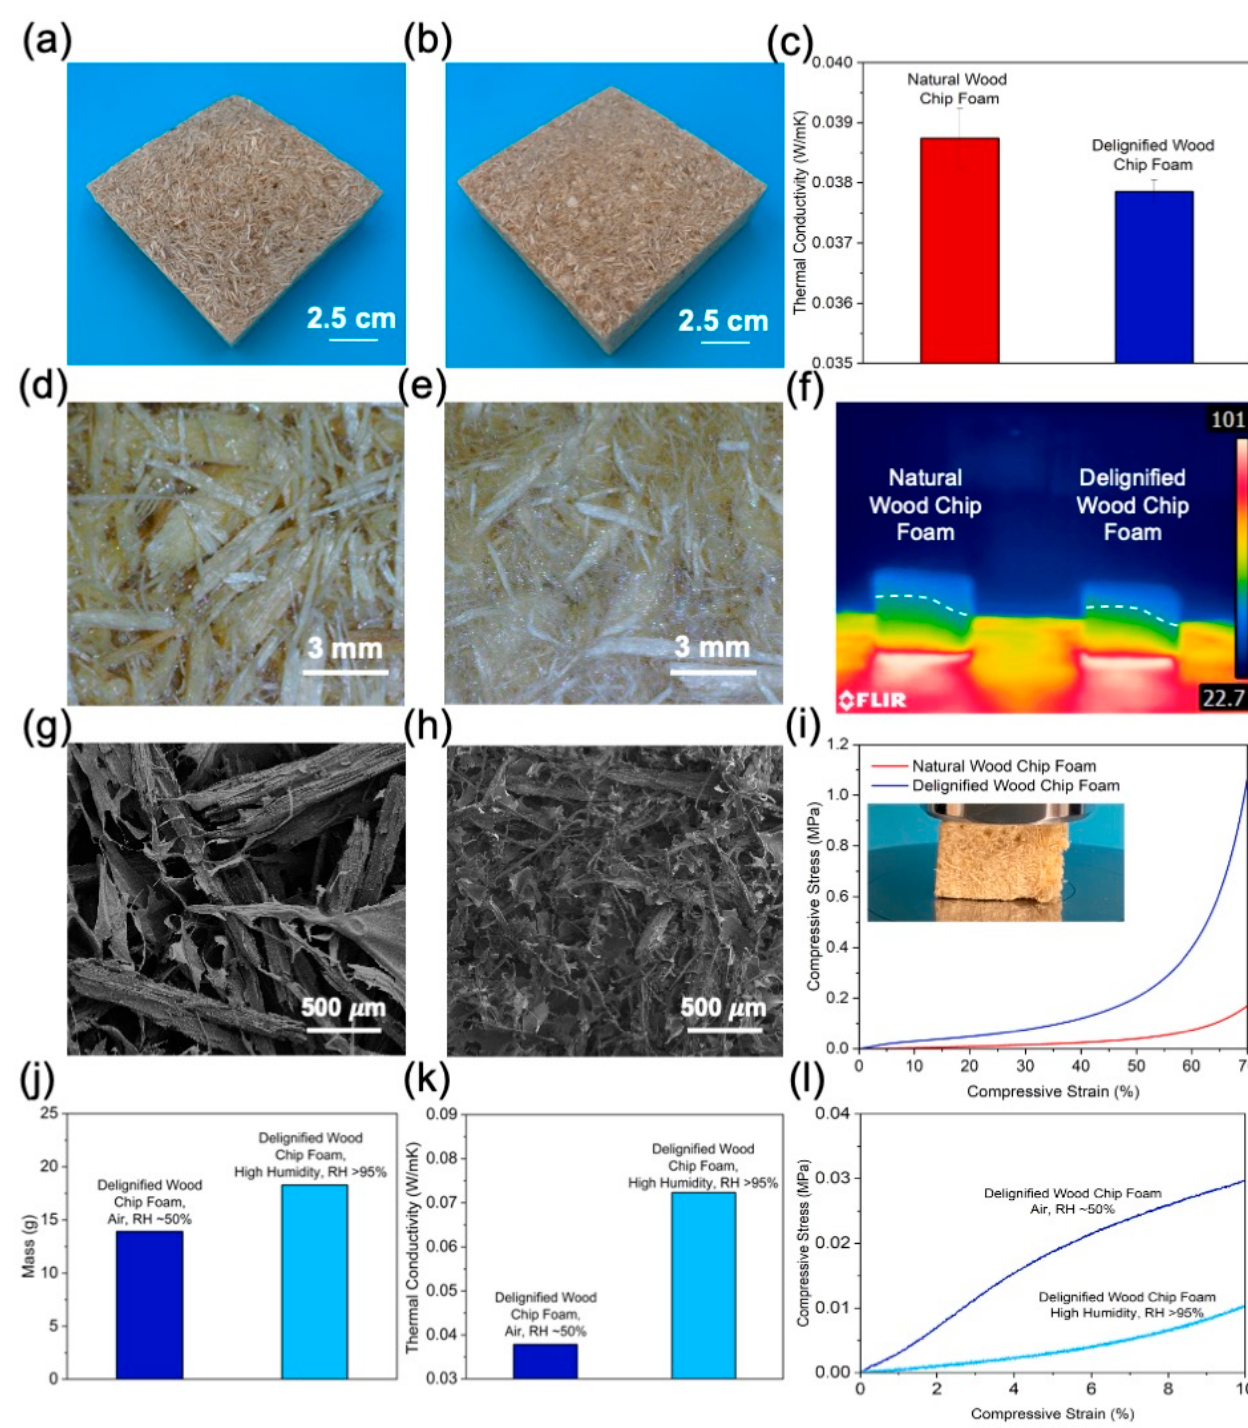
Figure 3. Performance properties of 15 wt.% CMC binder wood chip foams. ( a ) Natural and ( b ) delignified foams. ( c ) Thermal conductivities of the natural and delignified foams. Optical micro- scope images of the ( d ) natural and ( e ) delignified foams. ( f ) Infrared camera image. SEM images of the ( g ) natural and ( h ) delignified foams. ( i ) Compressive strength graph. Influence of moisture of the 15 wt.% CMC binder delignified wood chip foam on ( j ) mass, ( k ) thermal conductivity, and ( l ) compressive strength.